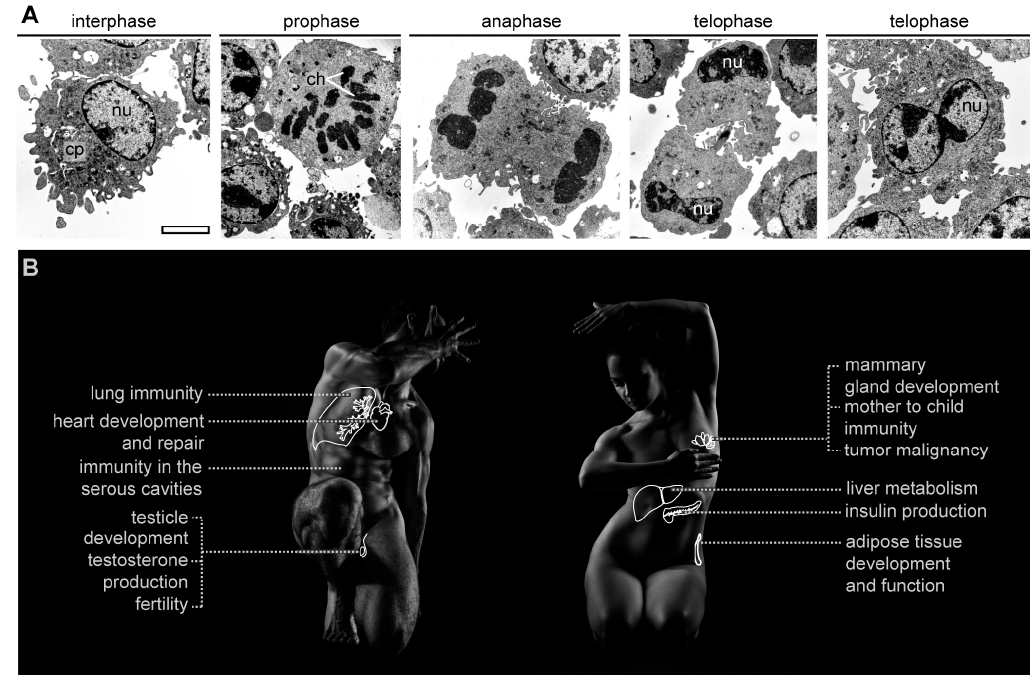
Figure 1. Self-renewing macrophages are key for organ development and function. ( A ) Transmission electron microscopy images of macrophages in the cell cycle. cp: cytoplasm, nu: nucleus, ch: chromosomes, scale bar 10 μ m; ( B ) Summary of developmental, repair, metabolic, and immune functions that are dependent on self-renewing macrophages.